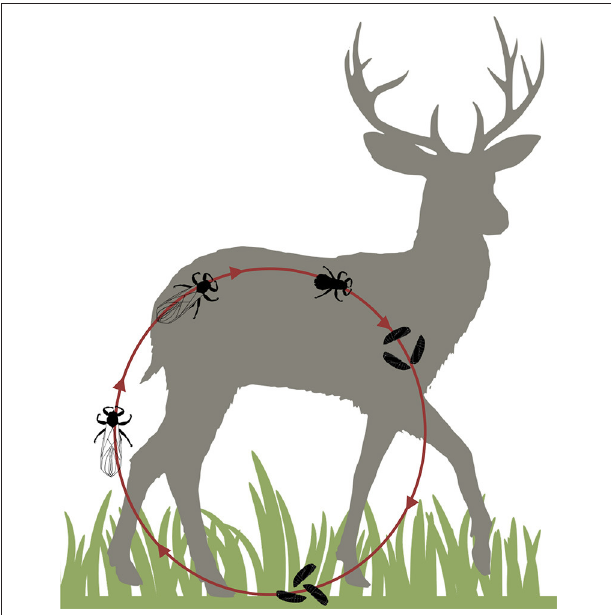
FIGURE 1 | Life cycle of deer keds. The winged adults fly to suitable hosts (mainly cervids) and lose their wings before sucking blood. They give birth to living larvae which fall to the ground as pupae and remain there until new adult deer keds hatch to find new